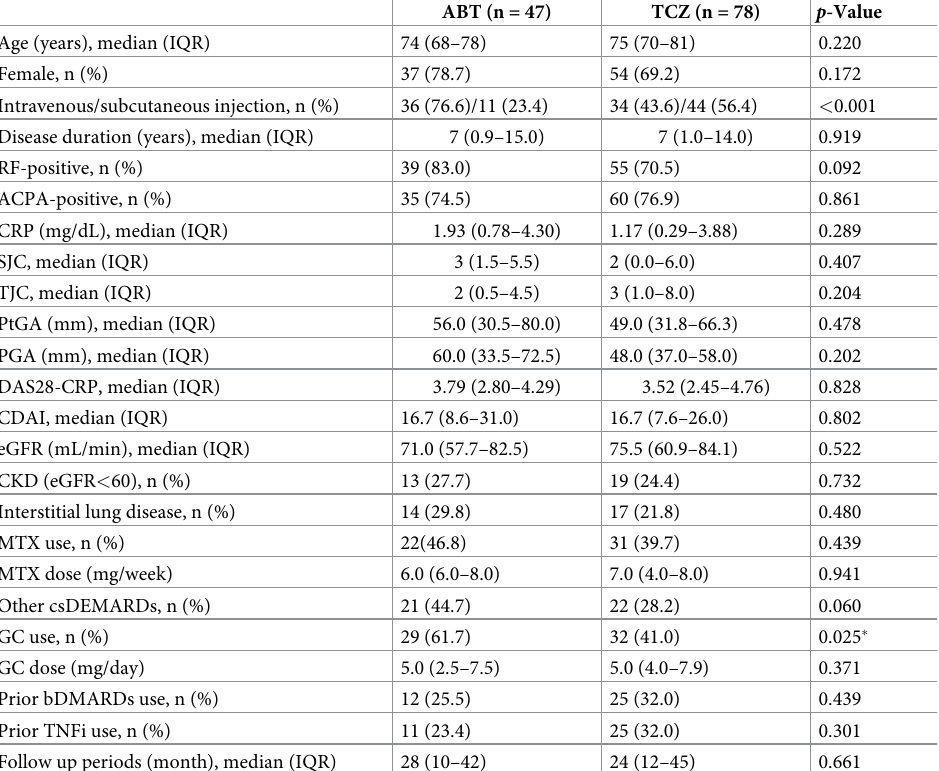
Table 1. Baseline characteristics between ABT group and TCZ group in elderly RA patients.